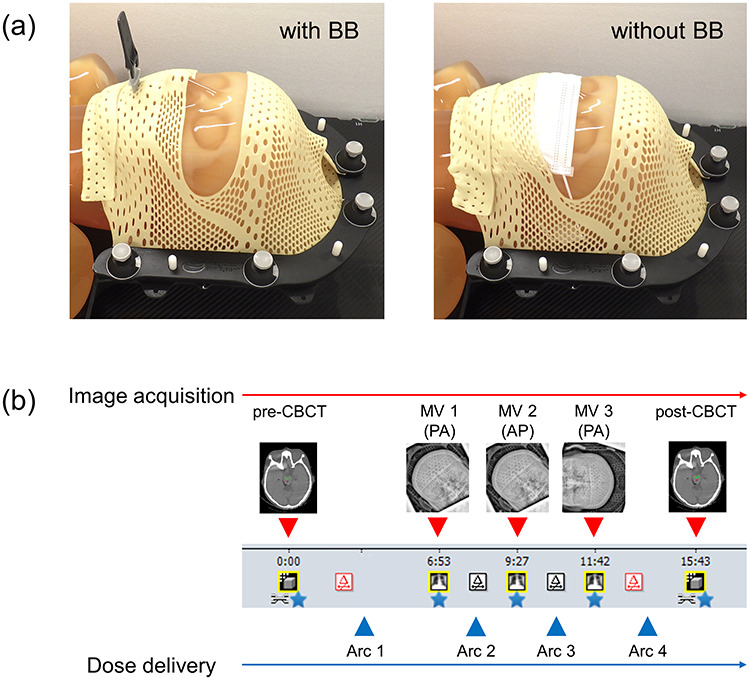
(a) Clam-shell-style thermoplastic masks with and without BB, and (b) workflow of image acquisition and STI dose delivery. The megavoltage images (MV 1 and MV 3) were acquired at a gantry angle of 179.9° (PA direction), while MV 2 was 0° (AP direction).